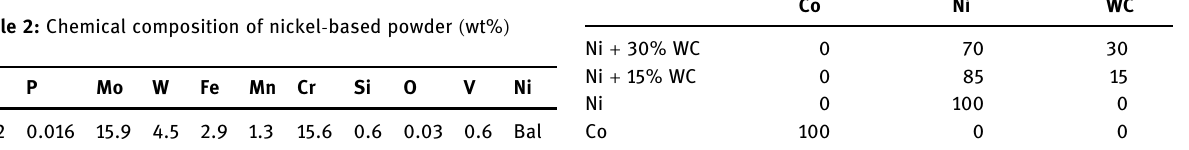
Table 2: Chemical composition of nickel - based powder ( wt% )